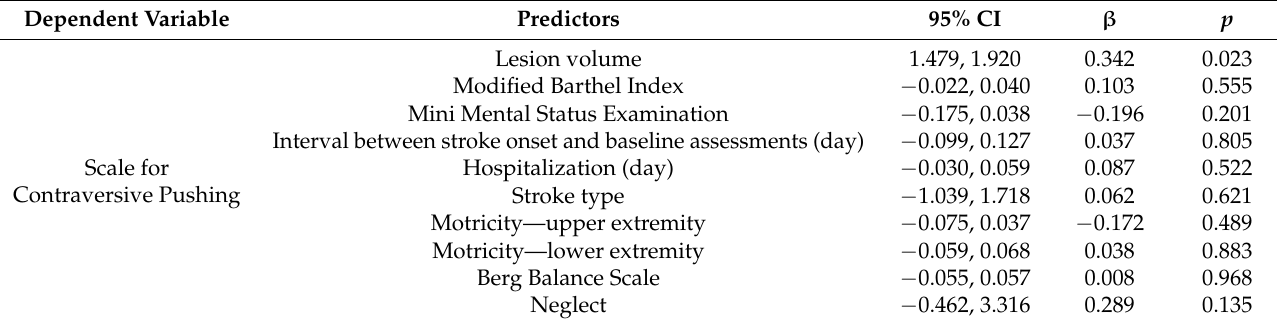
Table 2. Linear regression analysis of factors associated with Scale for Contraversive Pushing (SCP) scores.